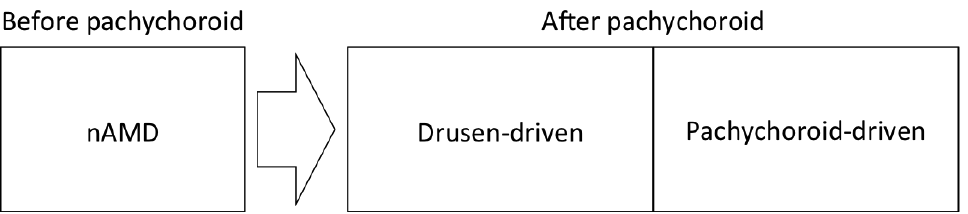
Figure 1. The framework for the subtypes of neovascular age-related macular degeneration (nAMD) in the era of the pachychoroid concept. Exudative maculopathy, previously diagnosed as nAMD, is divided into drusen-driven disease and pachychoroid-driven disease after the development of the pachychoroid concept.